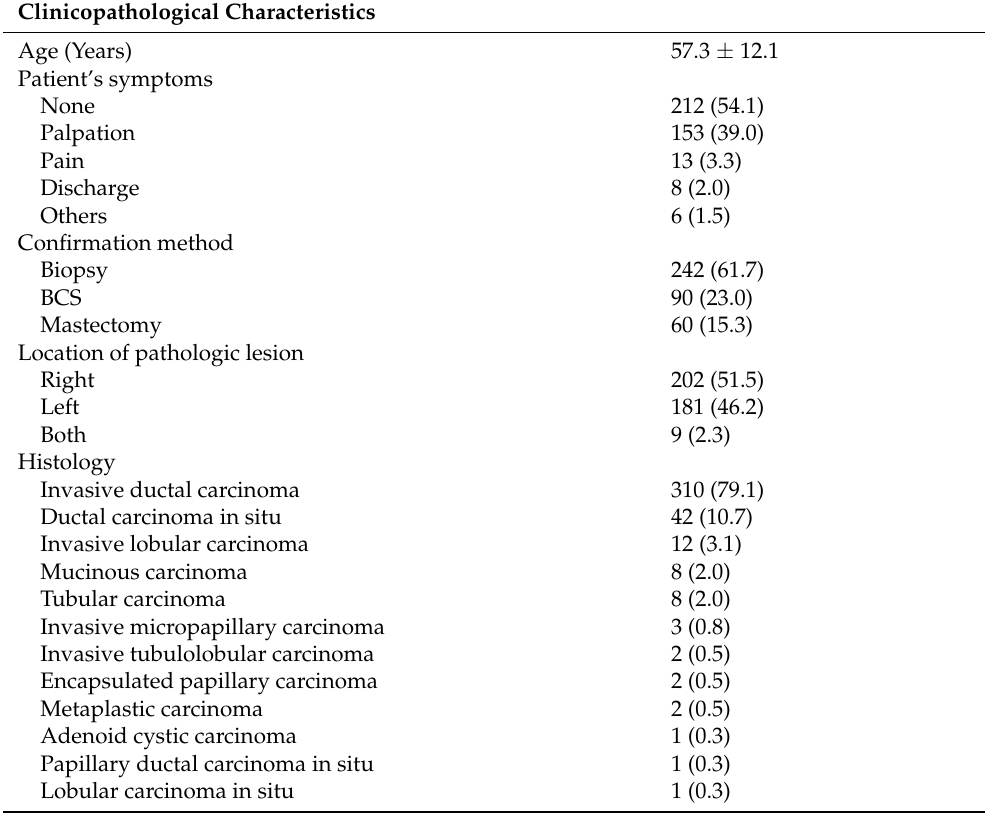
Table 1. Clinicopathological characteristics of study